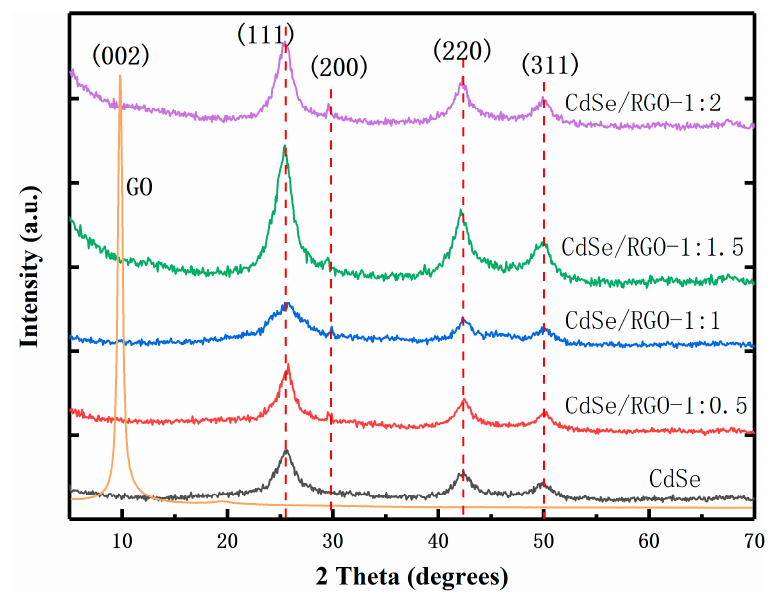
Figure 5. X-Ray Diffraction patterns of GO, CdSe/RGO-1:2, CdSe/RGO-1:1.5, CdSe/RGO-1:1 and CdSe/RGO-1:0.5.